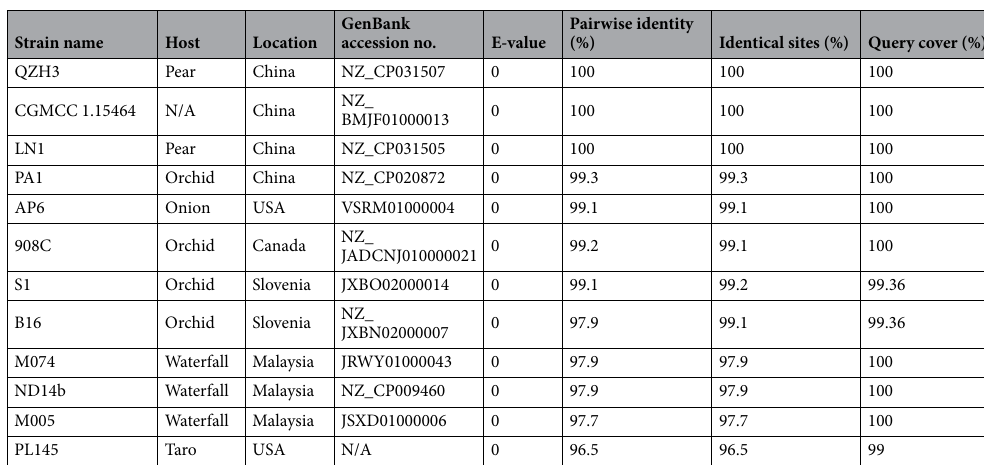
Table 1. Custom BLAST database results for Dickeya fangzhongdai MFS transporter gene region in all available genomes (draft and complete) retrieved from NCBI GenBank as well as one unpublished genome isolated in Hawaii (strain PL145). The MFS transporter gene sequence of D. fangzhongdai type strain CFBP8607 T was used for comparison.